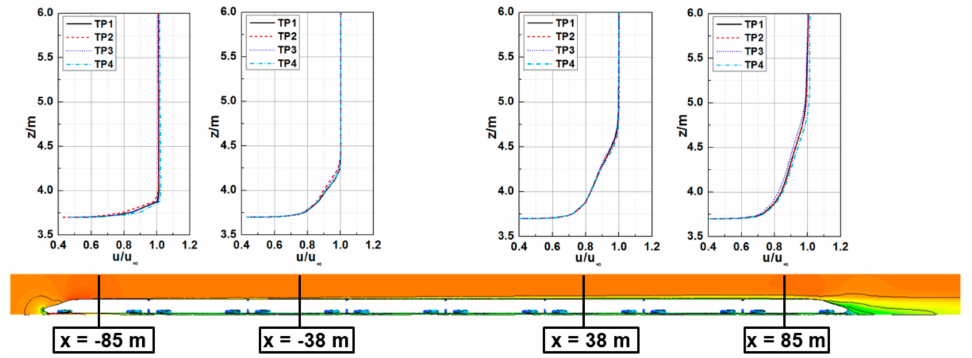
Figure 11. Velocity profile within the boundary layer at different section